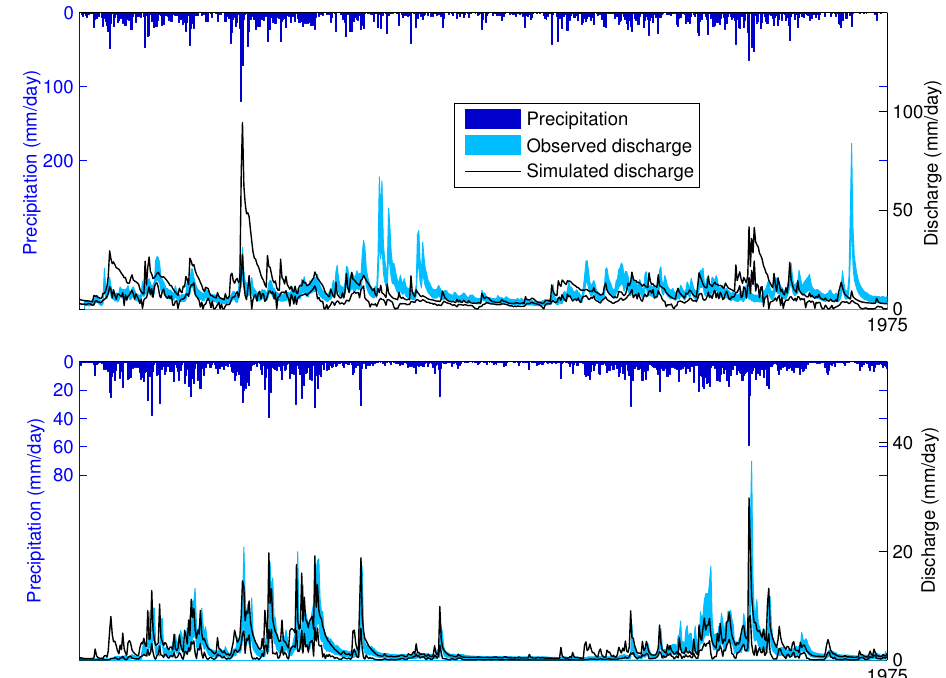
Figure 10. Precipitation, observed and simulated discharge (mmday − 1 ) at Bratsi, station no. 10 (top panel), one of the stations that had a poor correlation between observed discharge and CPI (0.12), and at Paiwas, station no. 18 (bottom panel) that had a high correlation between observed discharge and CPI (0.60). The simulated discharge was calibrated using FDCs calculated from local observed discharge and using the regional EPs.